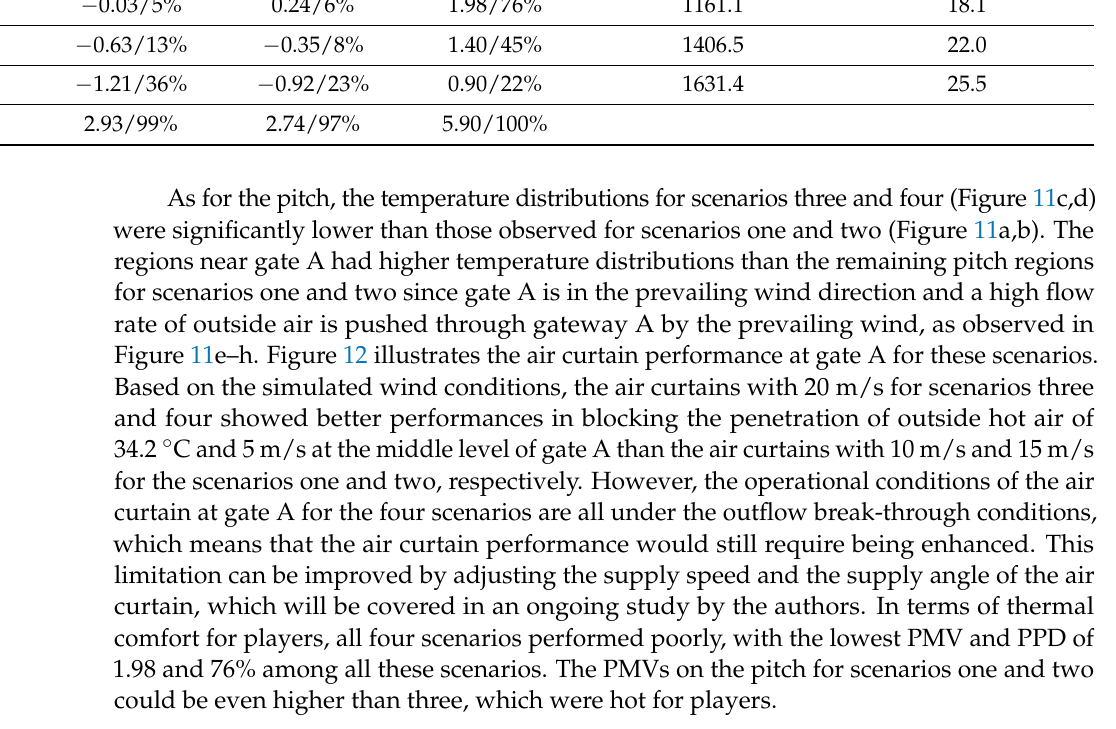
Table 7. Thermal comfort indexes and energy consumption estimations.